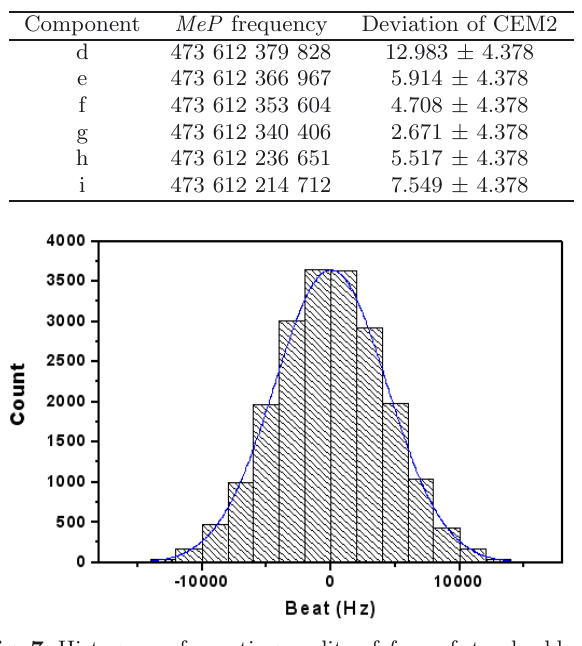
Table 1. Frequencies of d, e, f, g, h and i components of 633 nm laser measured by femtosecond comb at CEM, printed as a dif- ference from mise en pratique ( MeP ) values. All values in kHz.